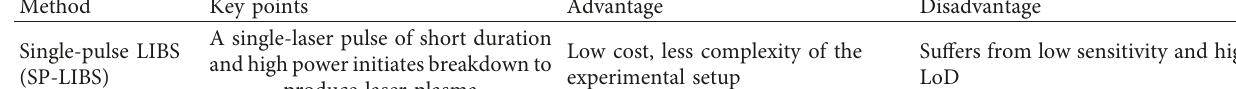
Table 1: Comparative study of different types of LIBS techniques used for trace element detection.